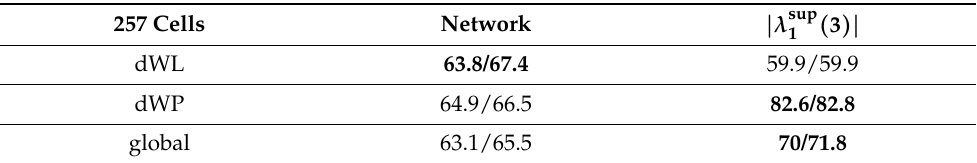
Table 6. Classification using Random Forests of the epithelial tissues. On the left, results using the number of neigbors and mean and variance of the degree. Best results are in bold. It can be seen that | λ sup ( 3 ) | performs 1